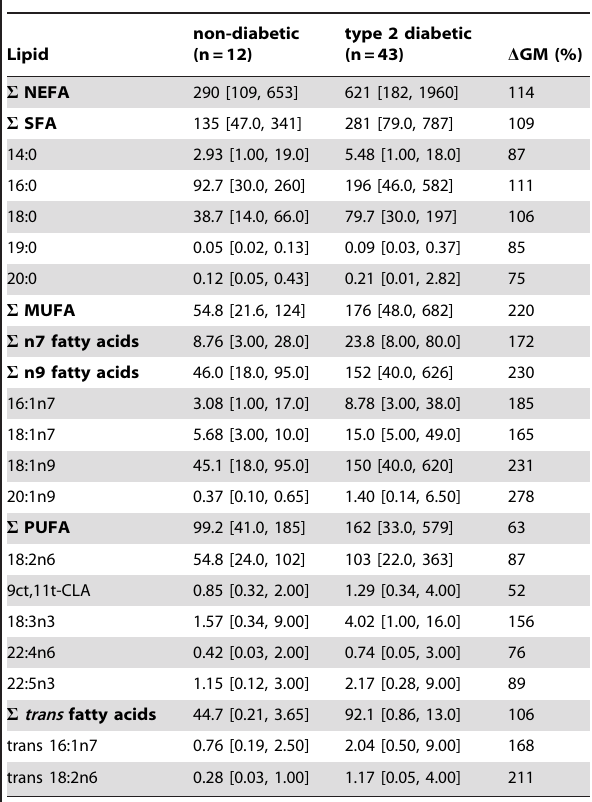
Table 1. Characteristics of overweight diabetic and non- diabetic African American Gullah-speaking female study participants.